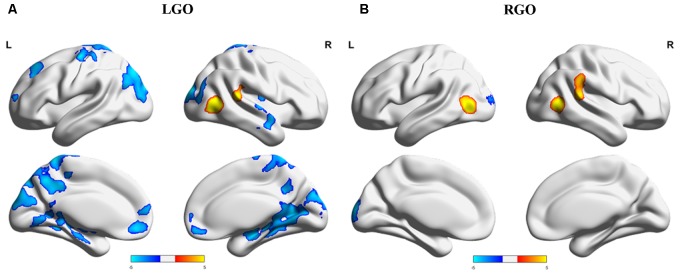
Overall difference in activation between NF and non-NF sessions (main effect of NF in the factorial analysis) for (A) LGO and (B) RGO tasks. Regions where NF > non-NF are shown in red-yellow colors, while regions where NF < non-NF are shown in dark-light blue colors. Statistical maps were thresholded using FWEc p < 0.05. LGO, imagined left hand gripping and opening and RGO, imagined right hand gripping and opening.